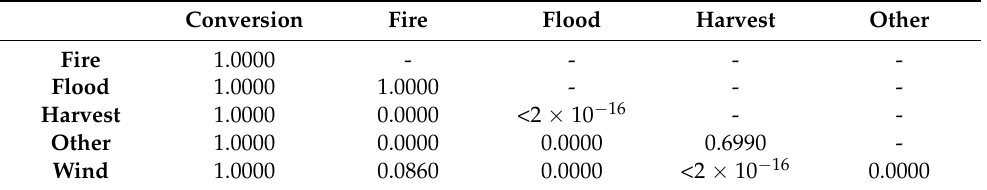
Table 7. p -values for pairwise comparison of AGB accumulation among agents following disturbance ( α =